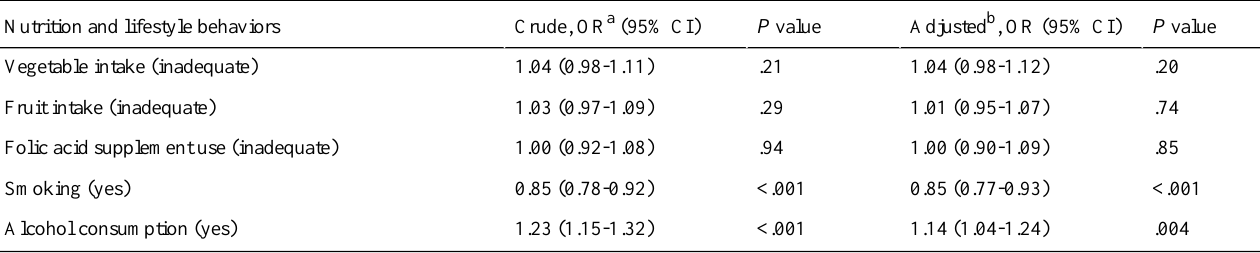
Table 3. The association between the neighborhood status score and inadequate nutrition and lifestyle behaviors in all participating women at the start of the program (N=2554).